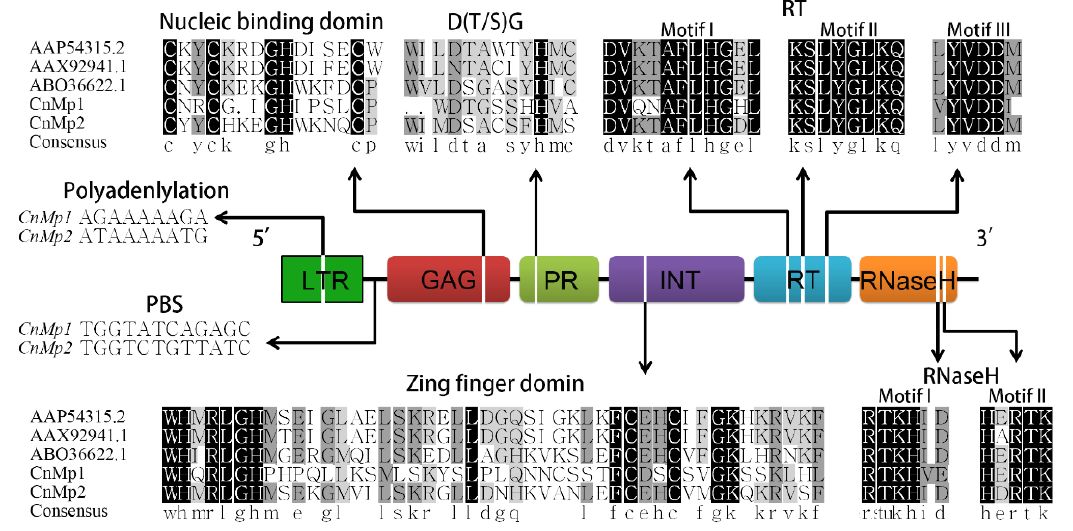
Figure 6. The conservative motifs of CnMp1and CnMp2. Entire conserved signatures among retroelements are indicated with black shading; partially conserved signatures are indicated with grey shading.